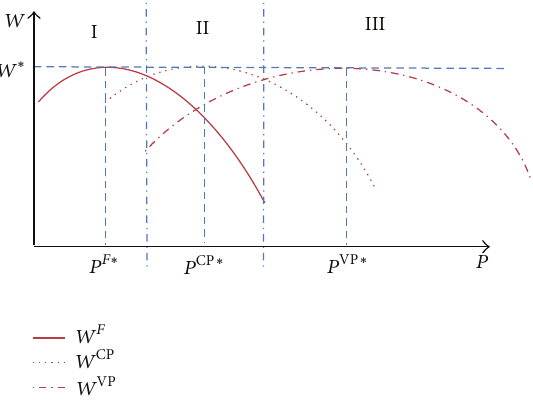
Figure 9: The comparison of three welfare functions.